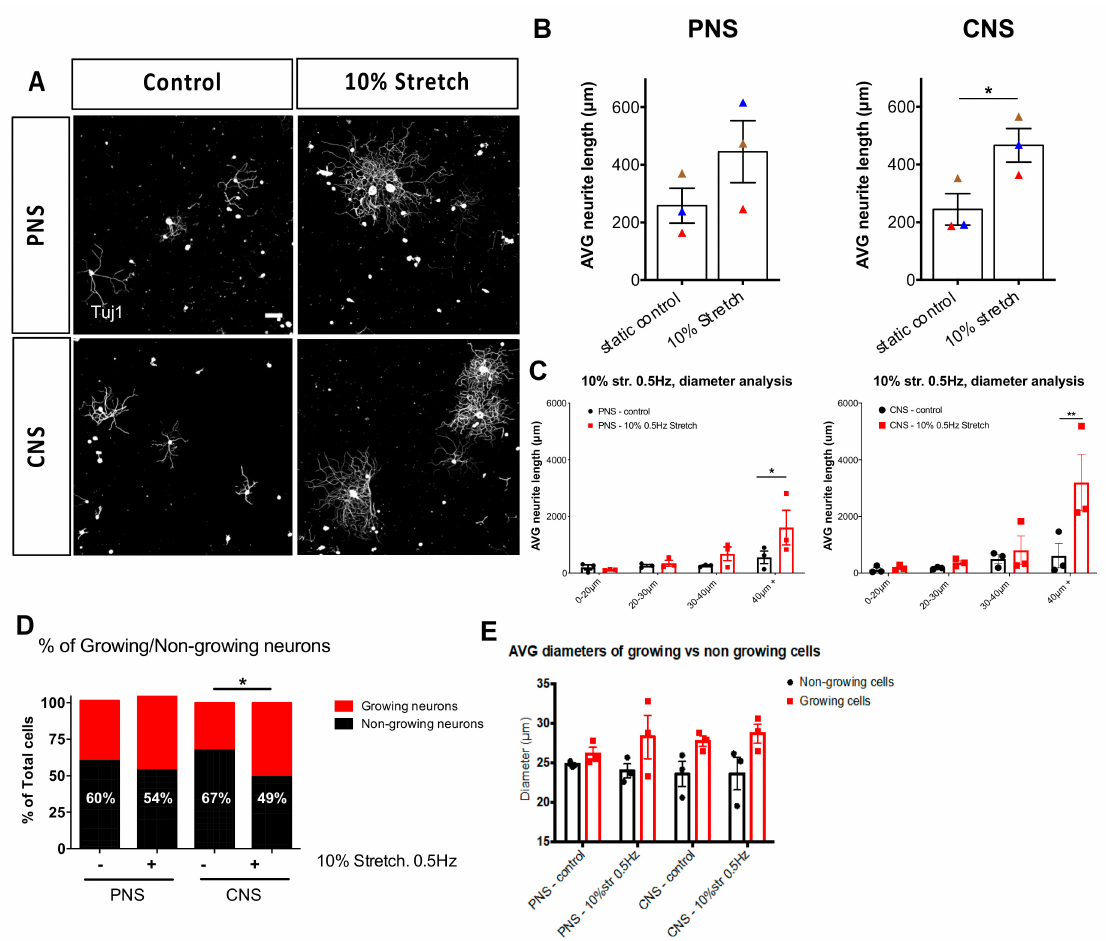
Figure 3. Ex vivo mechanical stretch enhances neurite outgrowth. Three hours following a mechanical stretch of either the sciatic nerve connected to L4-L5 DRG or connected to their respective central nerves, DRG were dissected and cultured for 18 h on laminin substrates. ( A ) Immunohistochemical staining of β III-tubulin (Tuj1) was used to trace all neurites of the DRG. Scale bar, 100 µ m, ( B ) 10% mechanical stretch with a frequency of 0.5 Hz enhanced neurite outgrowth of DRG derived from a CNS explant but not from a PNS explant. Paired two-tailed Student t -test, mean ± SEM of paired independent experiments indicated by the colors, * p < 0.05, ( C ) Diameter analysis of DRG outgrowth comparing the static controls to the stretched explants shows the largest neurons responding to stretch. Two-way ANOVA with post-hoc Sidak’s multiple comparison test, mean ± SEM, * p < 0.05, ** p < 0.01. ( D ) Quantification of growing vs. non-growing neurons in each group showed that non-growing neurons decreased in the CNS group upon the stretch. Two-way ANOVA with post-hoc Sidak’s multiple comparison test, * p < 0.05. ( E ) Examination of the average size of growing versus non-growing neurons shows non-growing neurons to be consistently smaller diameters than growing